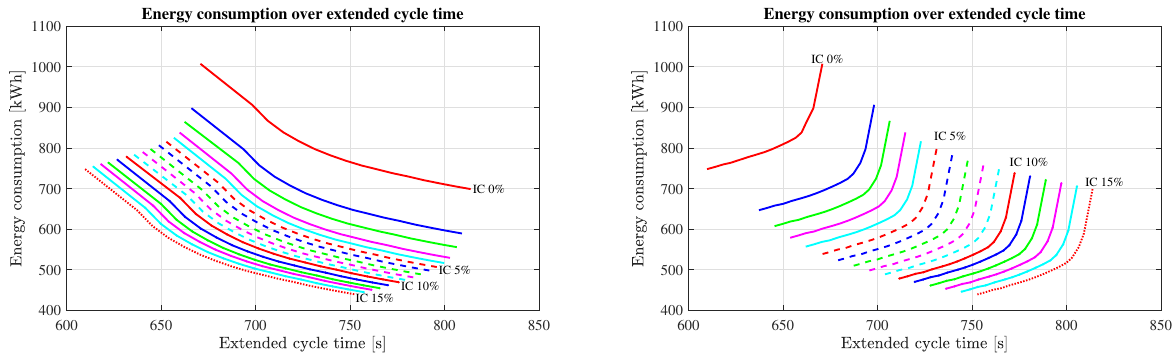
Figure 12: The left plot shows the energy consumption over the extended cycle time for the case Ah-Nm for fixed running time supplements of the IC and varying running time supplements for the SPR. The right plot indicates the energy consumption over the extended cycle time for fixed running time supplements of the SPR and varying running time supplements for the IC for the case